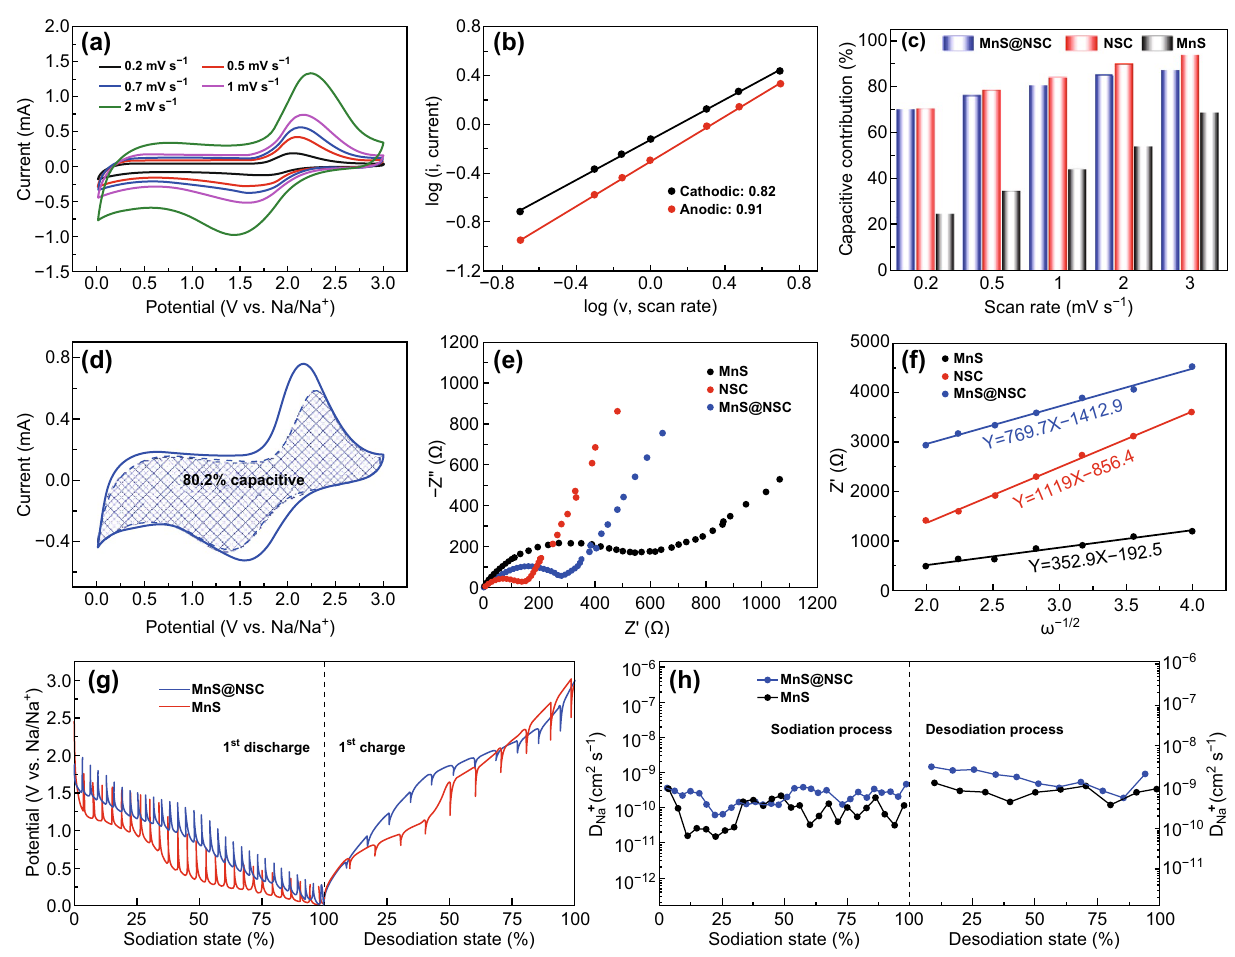
Fig. 4 a CV curves of MnS@NSC electrode at different scan rates. b Analysis of b value for cathodic and anodic peaks of MnS@NSC. c Capacitive contribution of MnS@NSC, NSC, and MnS electrodes at different scan rates. d Capacitive contribution of MnS@NSC electrode at 1 mV s −1 . e Nyquist plots of NSC, MnS, and MnS@NSC electrodes. f The relationship plots of Z ′ versus ω −1/2 at low-frequency region for NSC, MnS, and MnS@NSC electrodes. g GITT curves (repeated discharging the cells for 1200 s at 0.1 A g −1 followed by 1800 s relaxation) and h corresponding Na + diffusion coefficient at different discharge/charge states of MnS and MnS@NSC